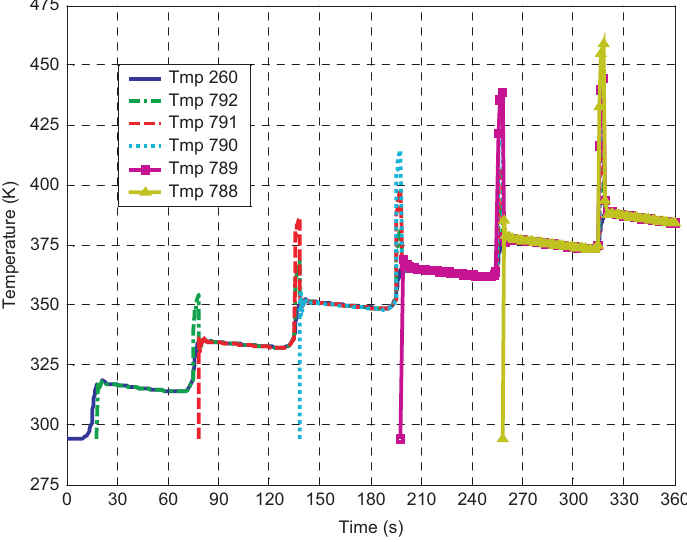
Figure 8 Temperature change at nodes 260, 792 – 788 along radial direction at the angle of 103.5 ° during 360 s (i.e., six rotations at 1 rpm), these nodes are shown in Figure